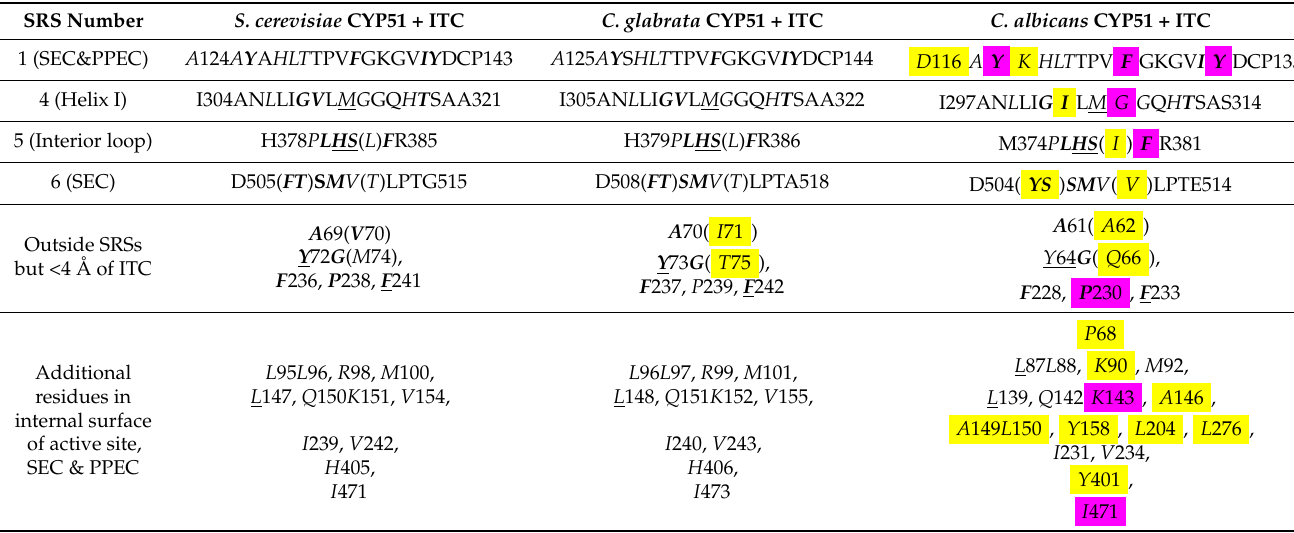
Table 1. Amino acid residues contributing the ligand-binding pocket in crystal structures of full-length fungal lanosterol 14 α -demethylases